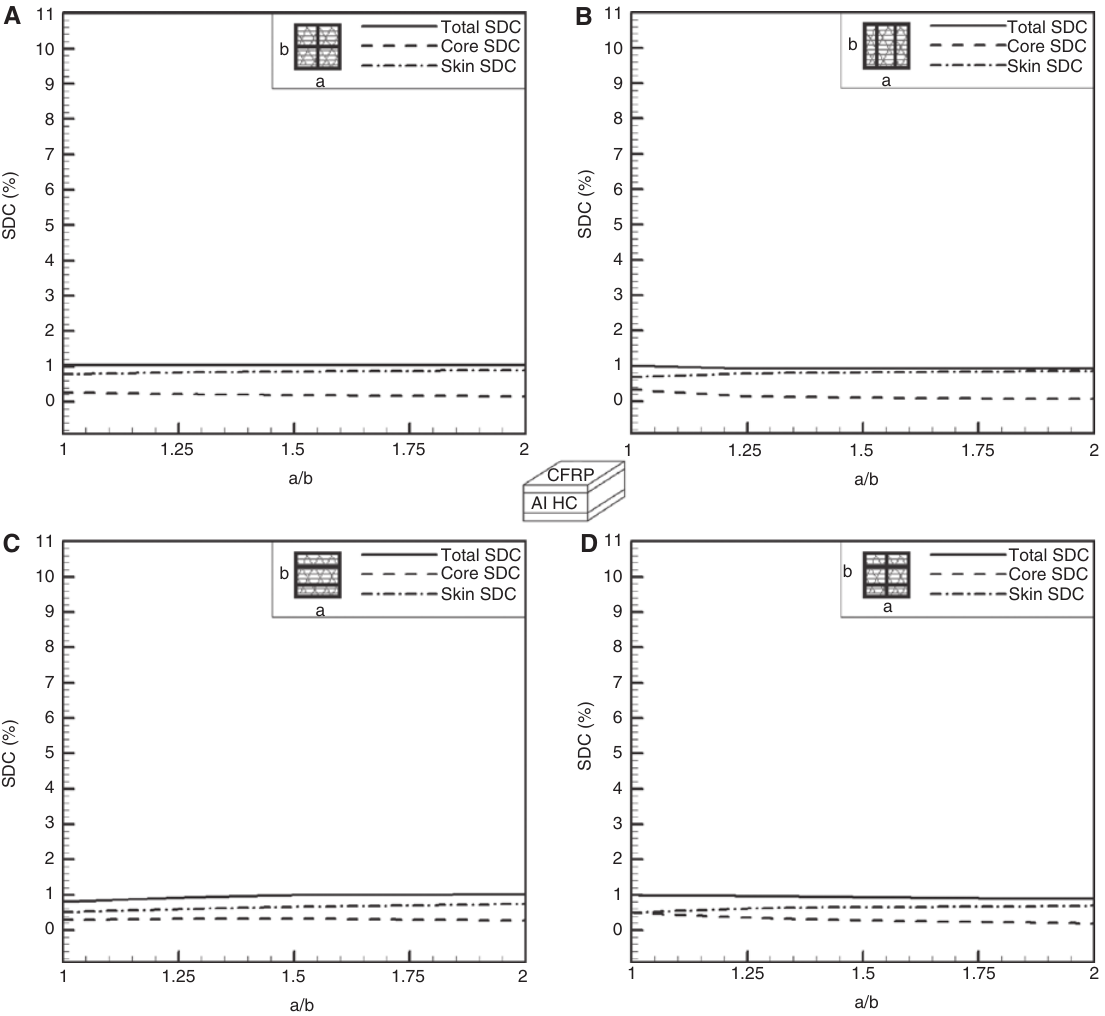
Figure 9: Damping of an all-free, [− 60, 0, 60] CFRP/Al honeycomb sandwich panel versus aspect ratio in various modes. (A) First mode, (B) second mode, (C) third mode, (D) fourth